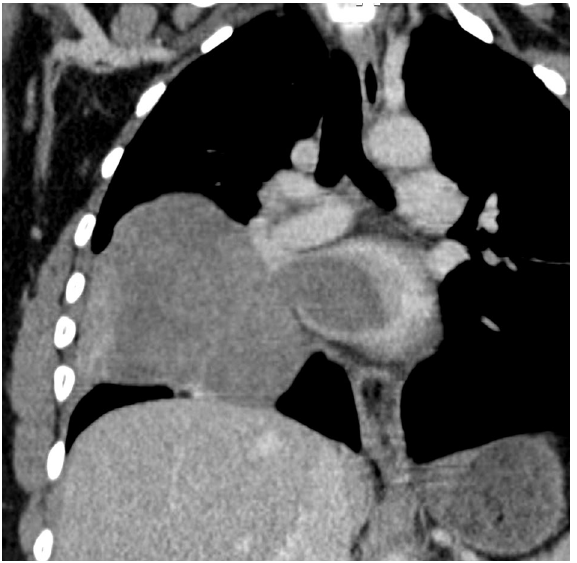
Figure 3. CT (coronal reconstruction): Right pulmonary mass, slightly enhanced after injection of contrast product with extension to the LA via the (RIPV) (Figure 2). Cardiac computed tomography (CT) revealed a large (100 (cid:1) 70 (cid:1) 100) mediastino-pulmonary mass extending to LA via RIPV (Figure 3).